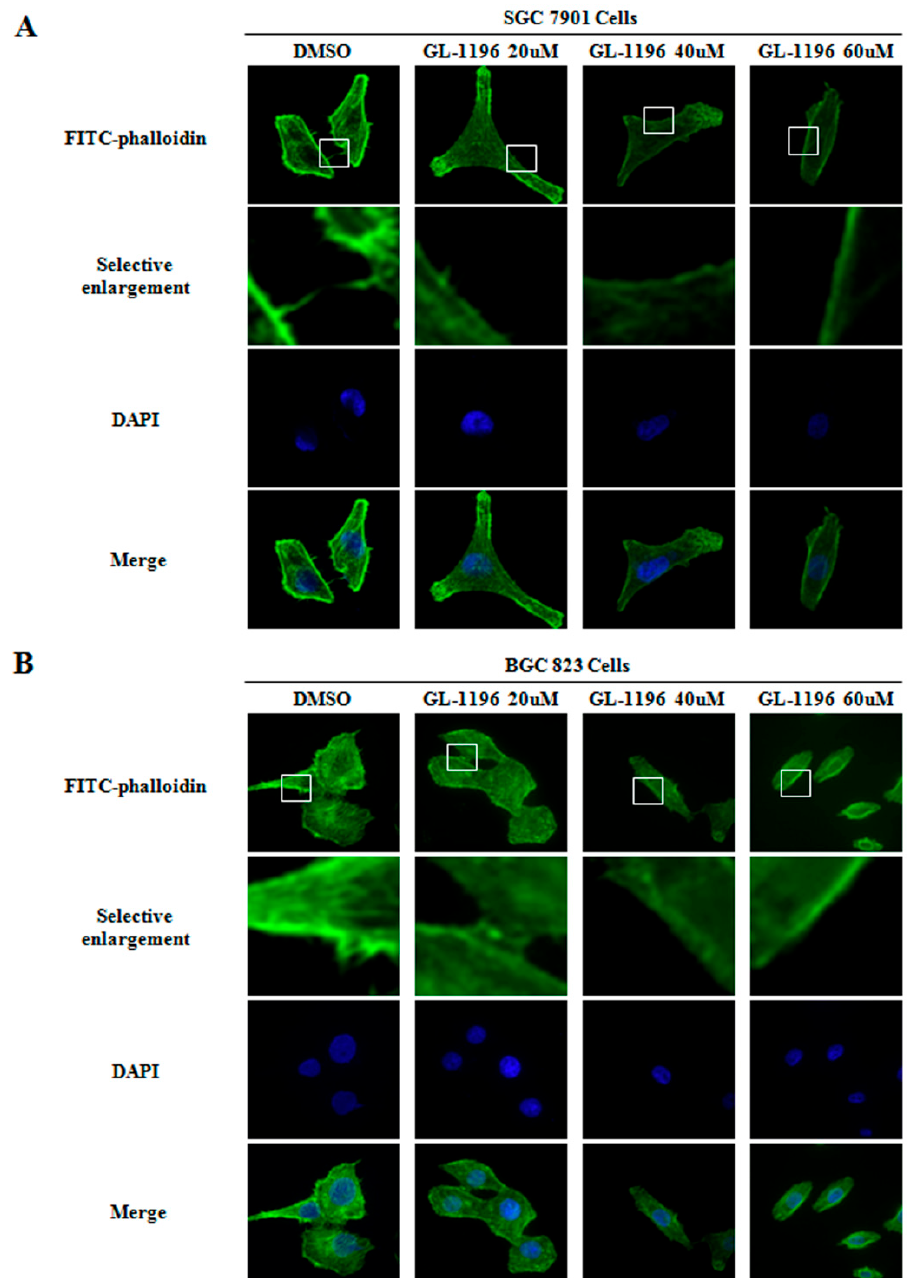
Figure 7. GL-1196 inhibits the formation of filopodia in SGC7901 ( A ) and BGC823 ( B ) cells. The magnification of the images is 400×. The blue fluorescence shows the nucleus stained with DAPI. Selective enlargement represents the magnifying images of scope within the white squares.